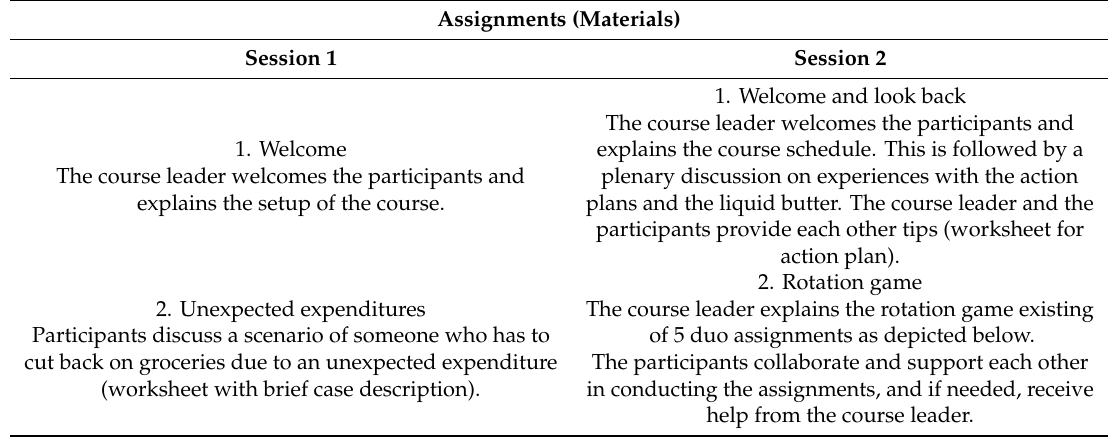
Table 1. Overview of the assignments in the two sessions of the Good A ff ordable Food intervention. Assignments